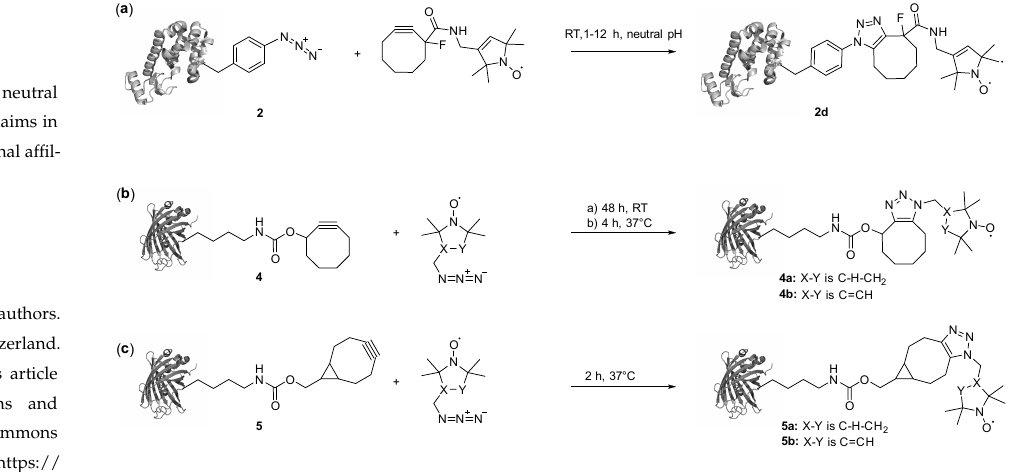
Figure 5. Conjugation of ncAA with nitroxide labels via strain-promoted azide–alkyne cycloadditions (SPAAC). The strained alkyne can either be part of the label reagent ( a ) or the ncAA ( b , c ). 2. The authors wish to add the grant number “ERC-CoG EPICODE to D.S., Grant Nr. 723863” to the Acknowledgments section.